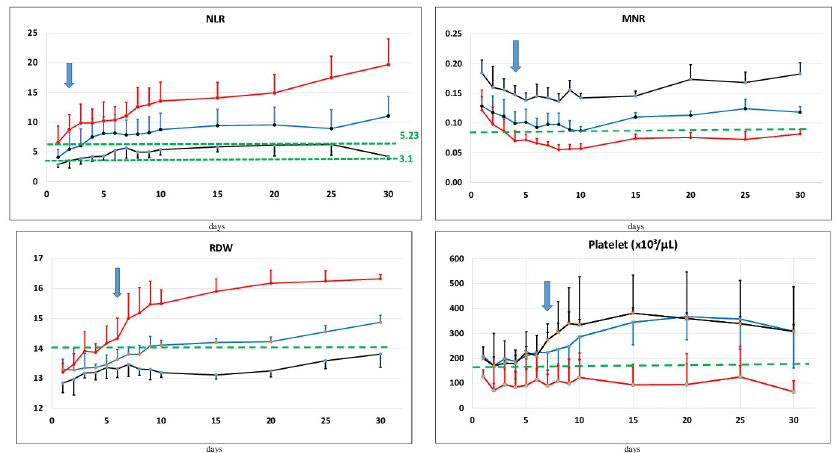
Fig 5. Trend graphics of time-related mortality risk factor parameters. Abbreviations: Black line: Non-critical survivors, Blue line: Critical-survivors, Red line: Non-survivors. Trends of CBC-Diff parameters over 30 Critical-non- survivors days of hospitalisation in mild/moderate, severe, non-survivor patients. 30 days of hospitalisation refers to Day 0 and the next days after admission. The reference range is displayed by the green dotted horizontal line. NLR: Neutrophil lymphocyte ratio, MNR: Monocyte neutrophil ratio, RDW-CV: Red Blood Cell Distribution Width-CV, PLT: Platelet ( x 10 3